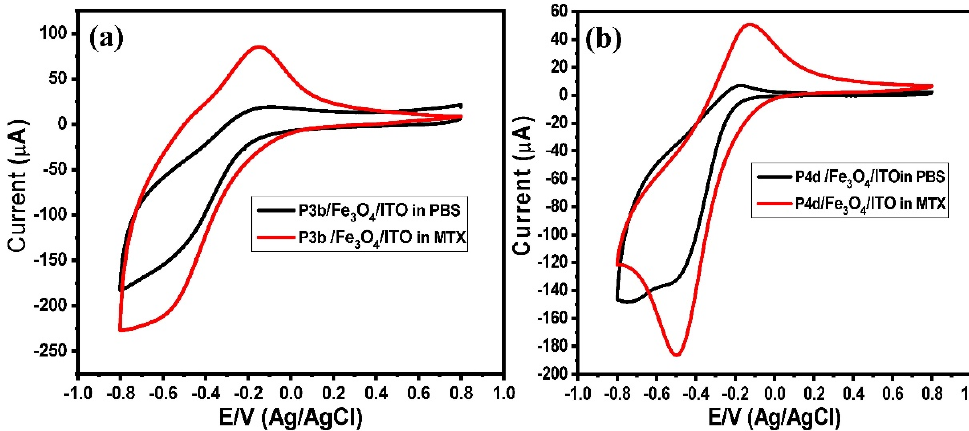
Figure 4. ( a ) CV of P3b/Fe 3 O 4 /ITO electrode in the buffer and MTX in buffer and 10 − 3 M MTX and ( b ) CV of P4d/Fe 3 O 4 /ITO electrode in buffer and 10 − 3 M MTX. ( b ) CV of P4d/Fe 3 O 4 /ITO electrode in buffer and 10